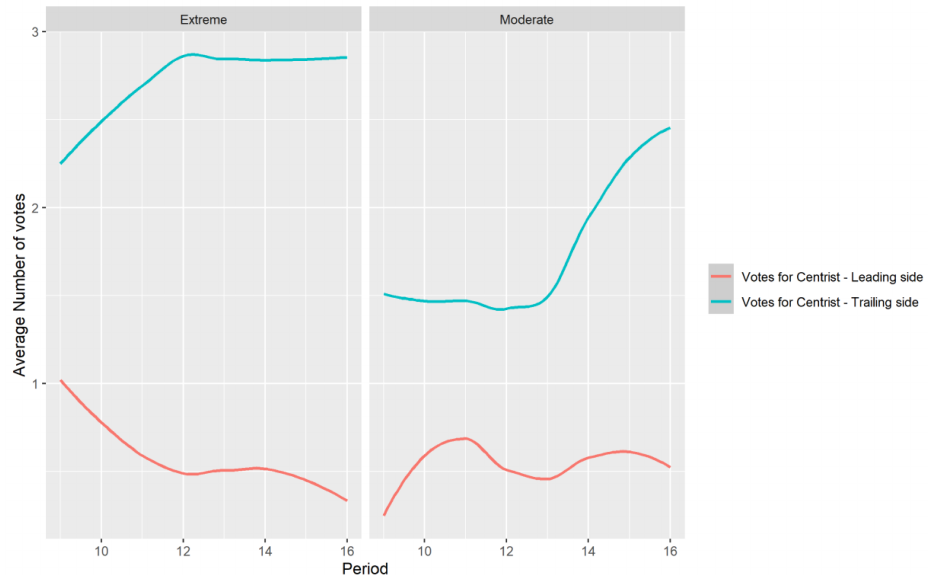
Figure 6. Average number of the centrist’s votes from the leading and trailing sides.